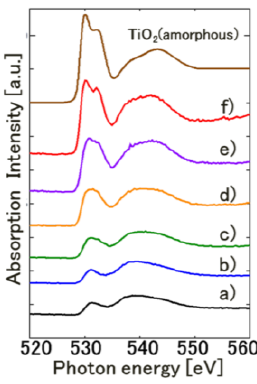
Figure 6. NEXAFS spectra of the C K -edge, before and after exposure to atomic oxygen. Fluences of atomic oxygen beam are ( a ) 0 atoms cm −2 , ( b ) 1.2 × 10 17 atoms cm −2 , ( c ) 1.2 × 10 18 atoms cm −2 , ( d ) 3.5 × 10 18 atoms cm −2 , ( e ) 1.2 × 10 19 atoms cm −2 , and ( f ) 1.9 × 10 20 atoms cm −2 . The spectrum of TiC powder is also shown for reference.